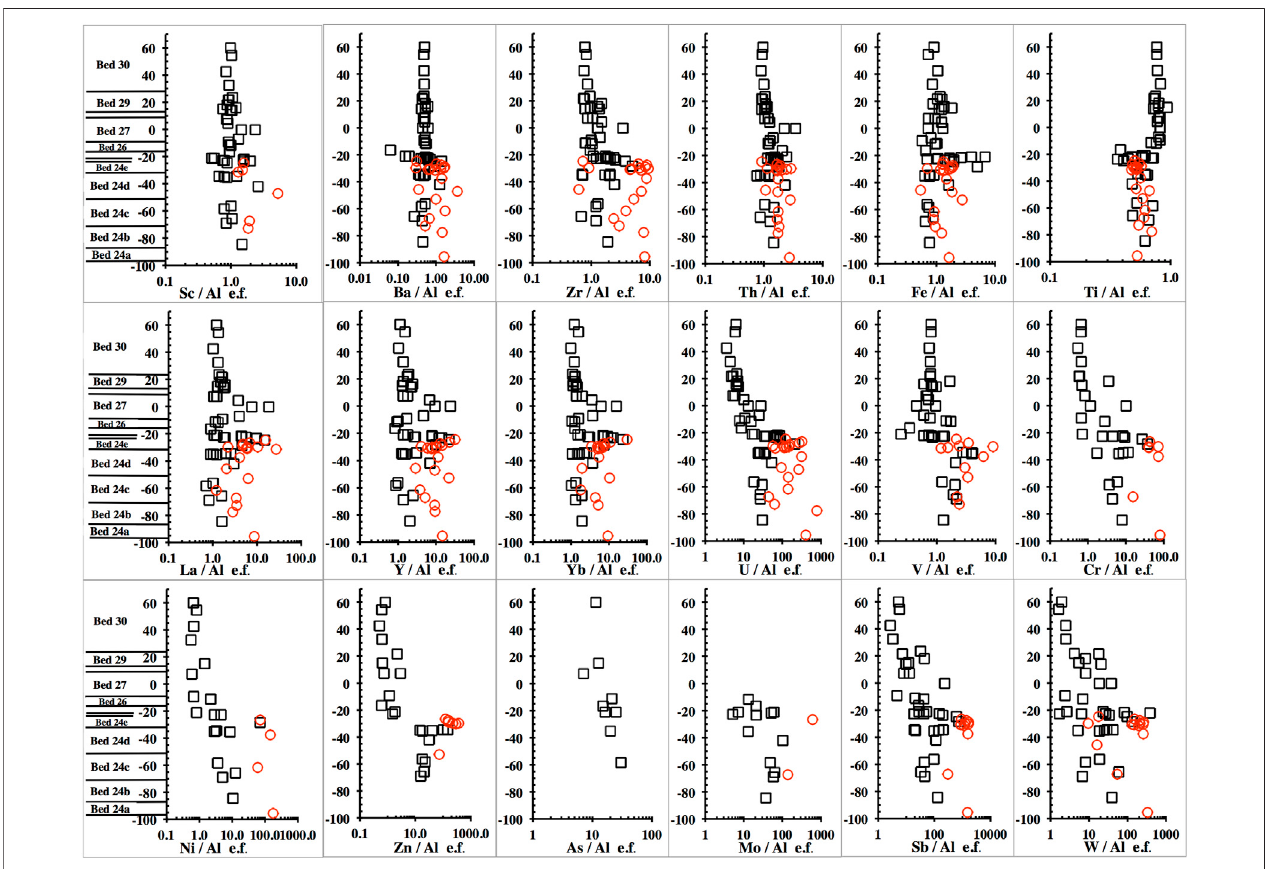
FIGURE8| Enrichmentfactors(ef)forwholerocktraceelementscalculatedwithrespecttoAlinPAAS.Samplescontaininglessthan0.5 wt%Fe 2 O 3T areshownin red. Concentration scales vary.